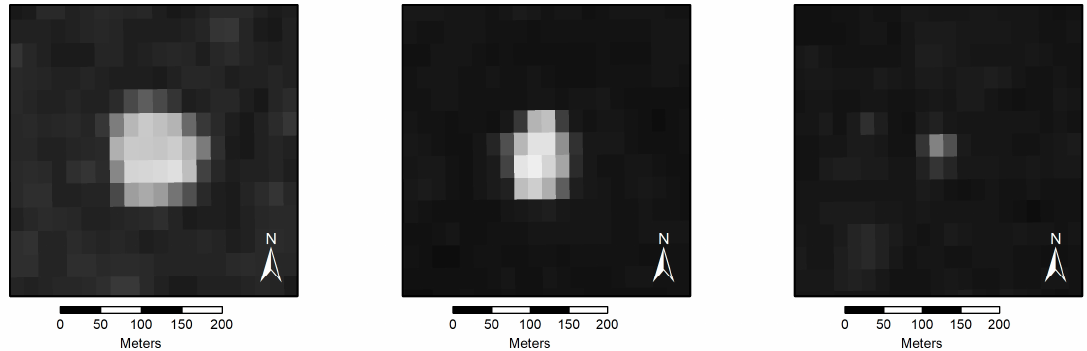
Figure 3. Size and brightness comparison of three royal Early Iron Age burial mounds in PALSAR data. Left: Tunnug 1 with a site diameter of around 140 m. Middle: Arzhan 5 with a diameter of 55 m. Right: Arzhan 4 with a diameter of > 100 m. All diameter measurements adapted from